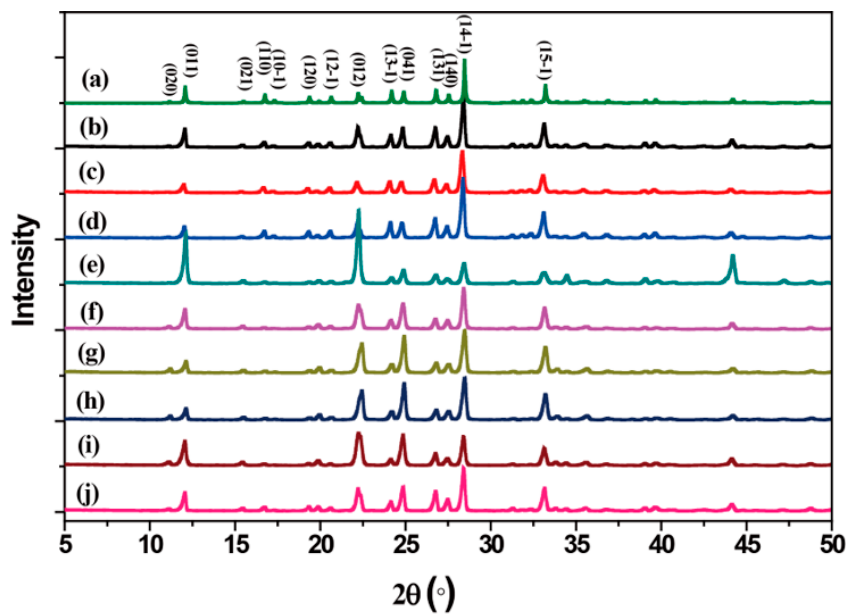
Figure 3. Powder X-ray diffraction patterns of ( a ) simulated, and ( b–j ) different shaped LLM-105 crystals obtained from varying antisolvent. ( b ) Water, ( c ) methanol, ( d ) acetic acid, ( e ) nitromethane, ( f ) ethyl acetate, ( g ) ethanol, ( h ) methylene chloride, ( i ) o-dichlorobenzene, and ( j ) toluene.